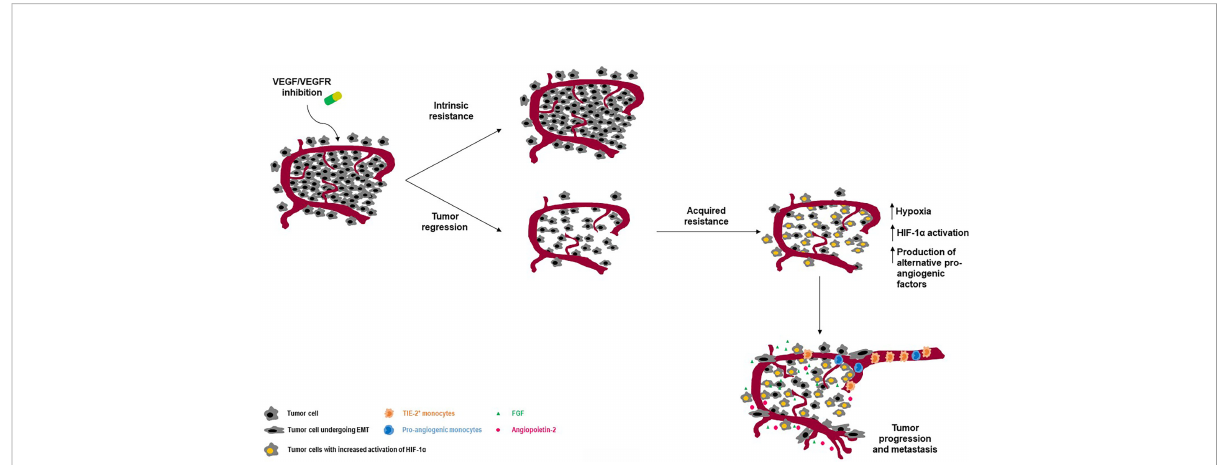
FIGURE 2 Intrinsic and acquired resistance to angiogenesis blockade: an overview on molecular determinants. While some tumors may show primary resistance to antiangiogenic agents, other may develop resistance upon blockade of the VEGF/VEGFR pathway. One of the main mechanisms leading to secondary resistance is the activation of HIF-1 as result of antiangiogenesis-induced hypoxia. Among other important events, there are the recruitment and/or activation of pro-angiogenic cells including TIE-2 expressing macrophages and the activation of the epithelial-to- mesenchymal transcriptional program in NEN